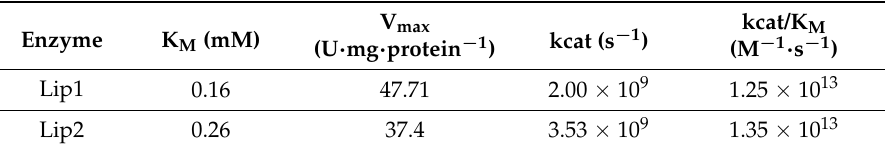
Table 4. Kinetic parameters of F. verticillioides purified lipases